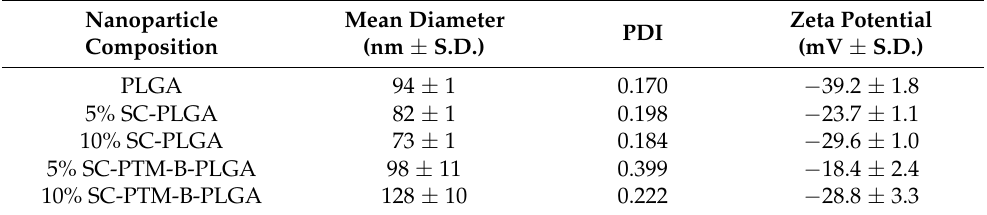
Table 1. Physicochemical characteristics (mean diameter, PDI and zeta potential) of PLGA nanoparti- cles (n =